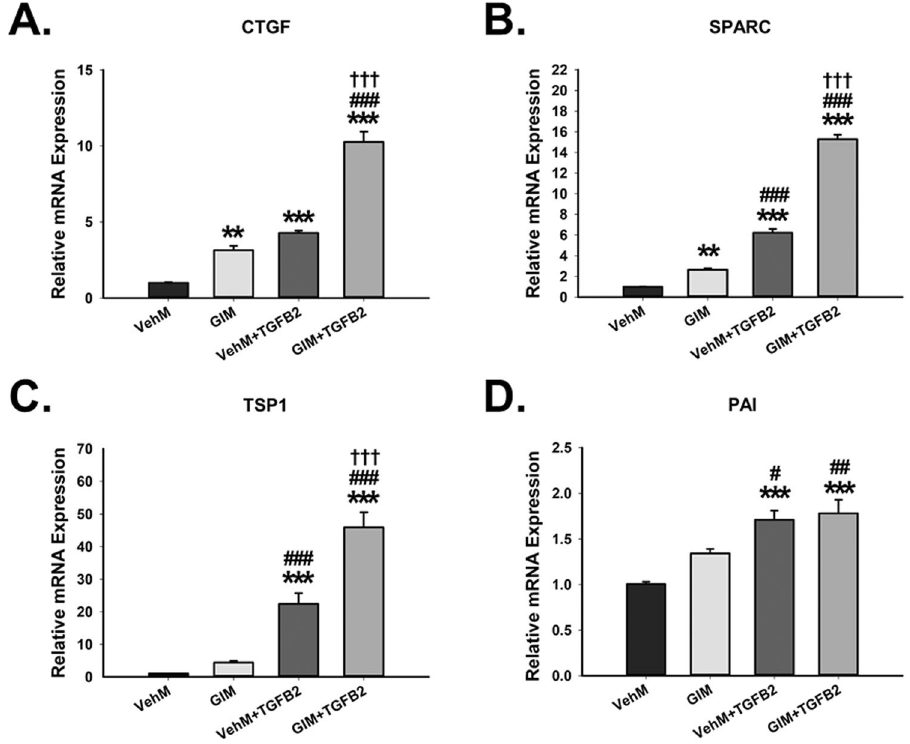
Figure 5. GIMs overexpress crucial matricellular genes with or without exogenous TGFβ2 in hTM cells. Primary hTM cells were cultured in the presence or absence of 100 nM dexamethasone for 4 weeks in complete growth media. Cells were subsequently removed using 20 mM ammonium hydroxide solution to obtain GIMs and vehicle control matrices (VehMs). Same strain, fresh primary hTM cells were then seeded on these matrices with or without exogenous 5 ng/mL TGFβ2 in 1% fetal bovine serum growth media for 7 days. RNA was extracted for reverse transcription and qPCR. GAPDH was used as an internal control for normalization. Bar graphs for (A) Connective tissue growth factor (CTGF), (B) Secreted protein acidic and rich in cysteine (SPARC), (C) Thrombospondin 1 (TSP1), and (D) Plasminogen activator inhibitor (PAI). Columns and error bars ; means and standard error of mean (SEM). One-way ANOVA with the Tukey pairwise comparisons post hoc test was used for statistical analysis. (n = 4 biological replicates. **p < 0.01, ***p < 0.001 for the group of interest versus control, VehM. # p < 0.05, ## p < 0.01, ### p < 0.001 for the group of interest versus GIM. ††† p < 0.001, for VehM + TGFβ2 versus GIM + TGFβ2). hTM, human trabecular meshwork. GAPDH, Glyceraldehyde 3-phosphate